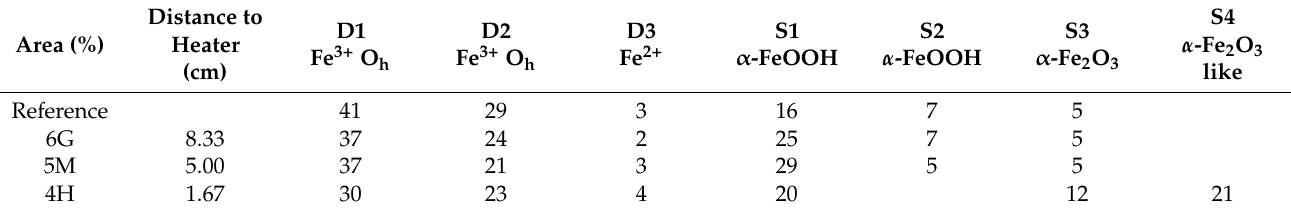
Table 8. Relative areas obtained from the fit of the spectra presented in Figure